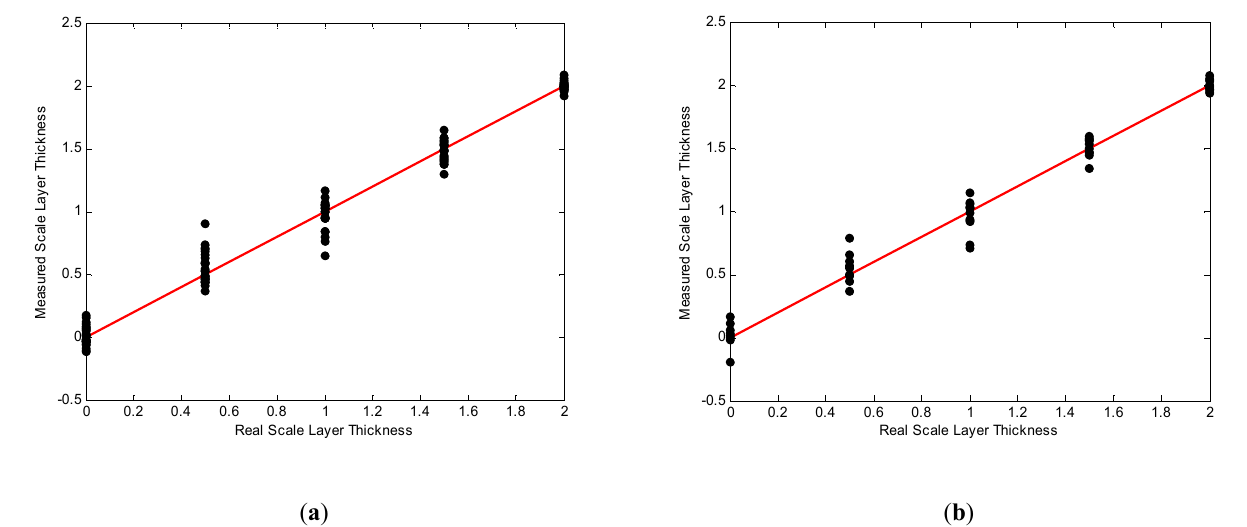
Figure 8. Measured scale value versus real data for ( a ) training and ( b ) testing sets. Table 3. Errors of the designed RBF neural Table 2. The input matrix, output matrix, and measured data (network output) for the testing set (54 cases).